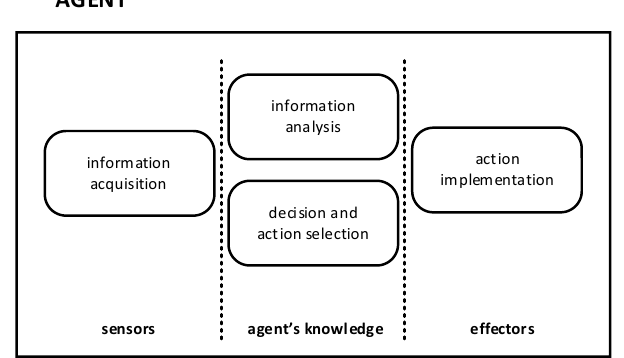
Figure 2. The functional classes of the agent structure.